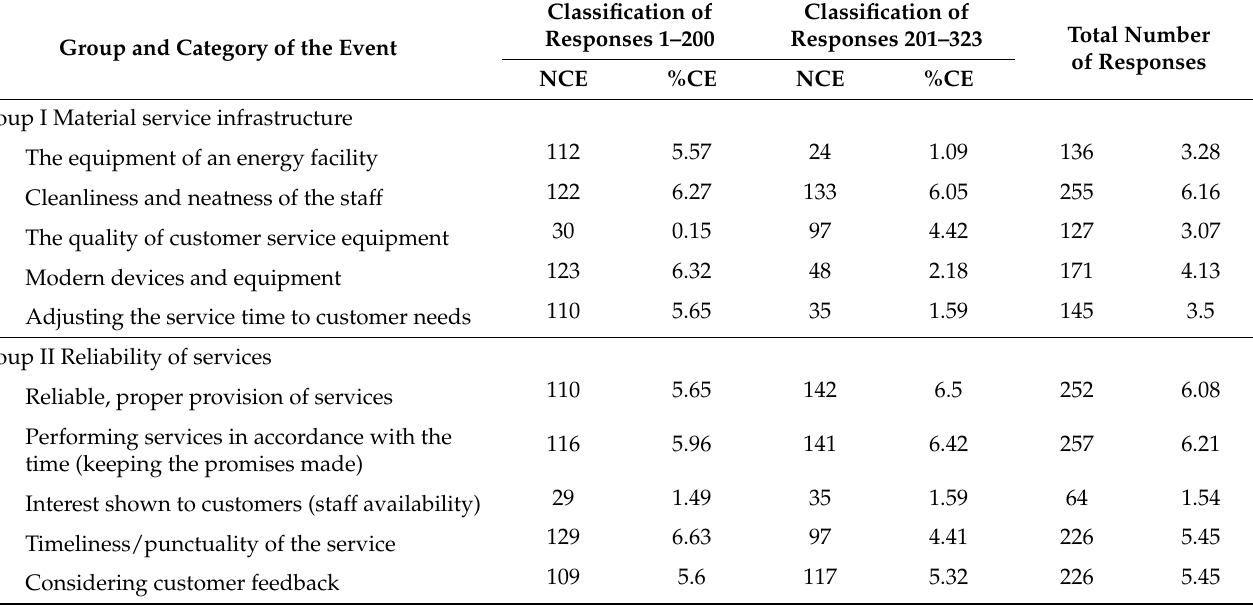
Table 2. Classification of critical events in energy services (NCE—the number of critical events, %CE—the percentage of critical